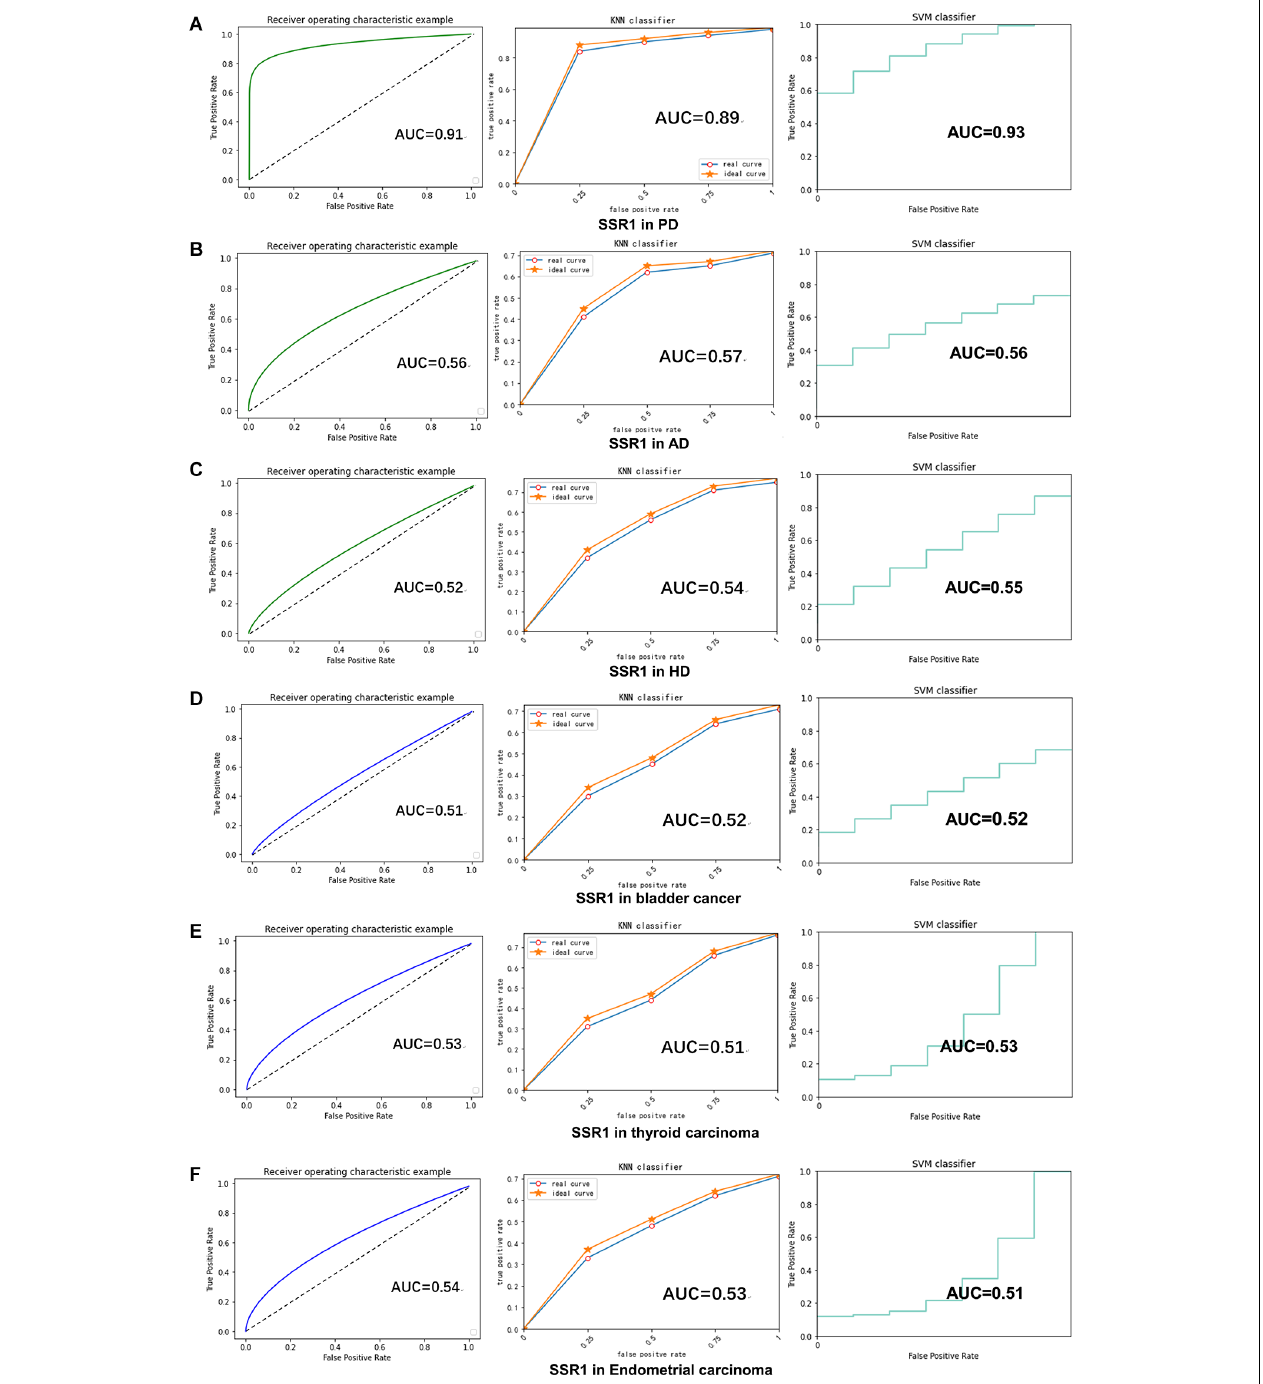
FIGURE 8 | SSR1 in artificial intelligence prediction model. (A) The ROC curve of the sensitivity for the diagnosis of PD based on SSR1 from RF (left), KNN analysis (middle), and SVM analysis (right). (B–F) The ROC curve of the specificity for the diagnosis of PD based on SSR1 in AD (B) , HD (C) , Bladder cancer (D) , Thyroid carcinoma (E) , and Endometrial carcinoma (F)